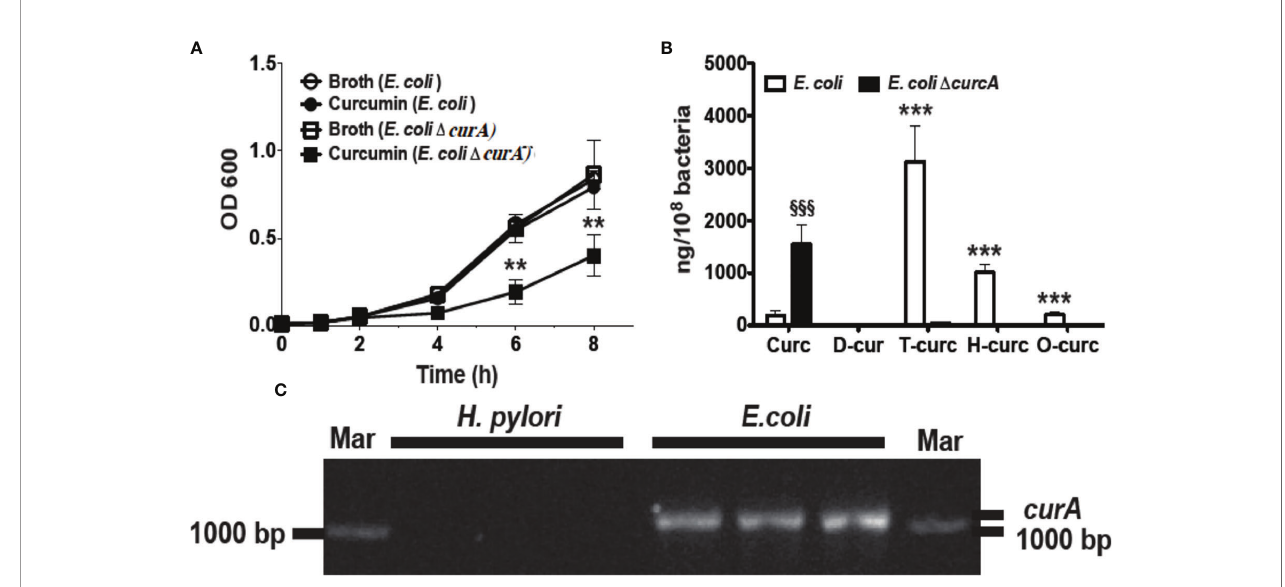
FIGURE 3 | Deletion of curA gene in E. coli results in growth inhibition by curcumin. (A) Growth curve of E. coli and its deletion mutant ( D curA ) in the presence of curcumin or vehicle (** P value < 0.005 *** P value < 0.005). The deletion of curA was done by PCR splicing method in which a pair of primers fl anking the region where the deletion to be made, two complementary primers comprising a region of -15 bp to +15 bp related to the junction point were used and a high fi delity polymerase was used for PCR. (B) Quanti fi cation of curcumin and its reduced metabolites dihydro-curcumin (D-curc), tetrahydro-curcumin (T-curc), hexahydro- curcumin (H-curc), and octahydro-curcumin (O-curc) in E. coli and its curA deletion mutant. (C) RT-PCR analysis of curA expression in genomic DNA isolated from H. pylori or E. coli . §§§ P ≤